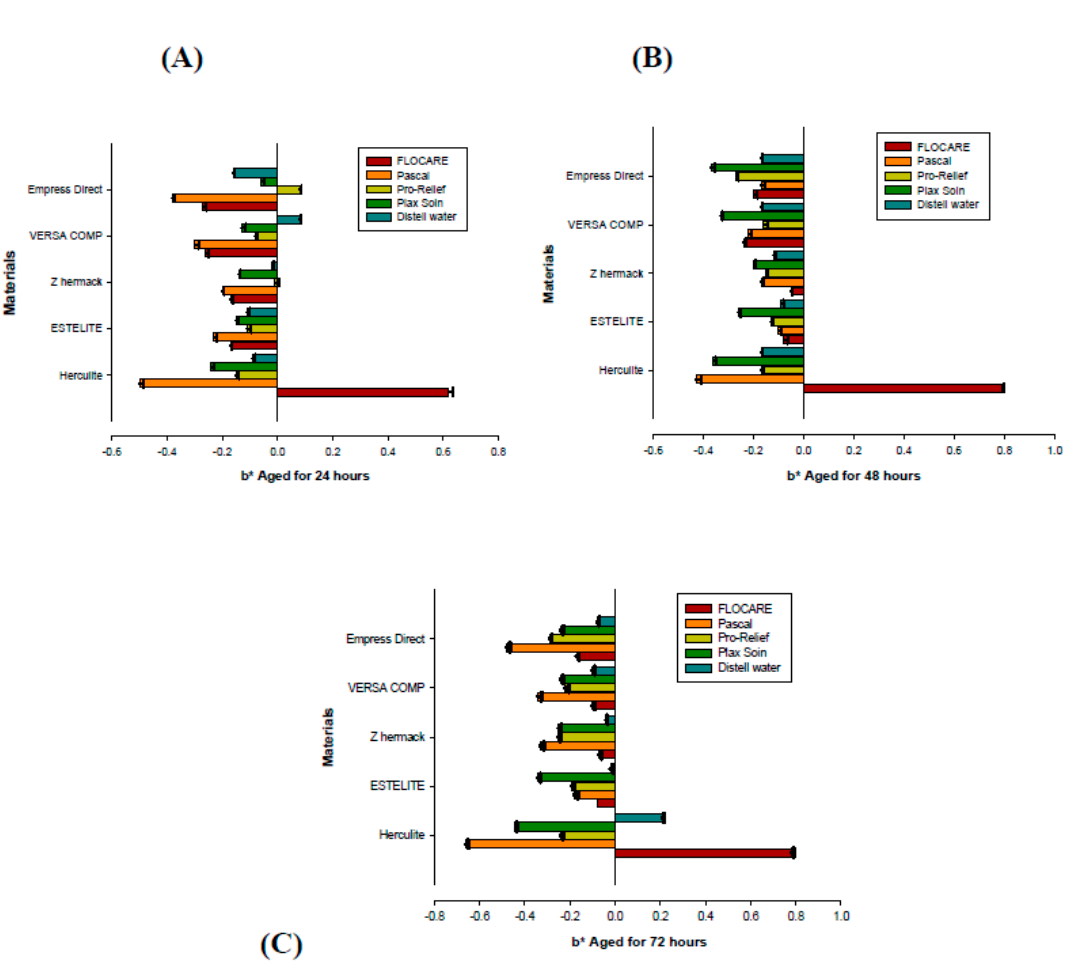
Figure 1. The color difference ( Δ b*) of the composite resin materials in response to various preventive anti-caries gels and mouth rinse solutions after aging: ( A ) 24 h; ( B ) 48 h; ( C ) 72 h. The Δ b* in Group 2 (Pascal anti-caries gel (APF preventive gel)), was imperceptible to the human eye at all aging times, where Δ b* < 1.5 (clinically acceptable). The color shifting for this group was towards the blue axis; all materials at 48 h of immersion showed a decrease in their blueness values compared to 24 h; at 72 h of immersion, the shifting of the color for all materials was highly increased, again towards blueness. The shift was statistically significant ( p = 0.016), but imperceptible to the human eye.